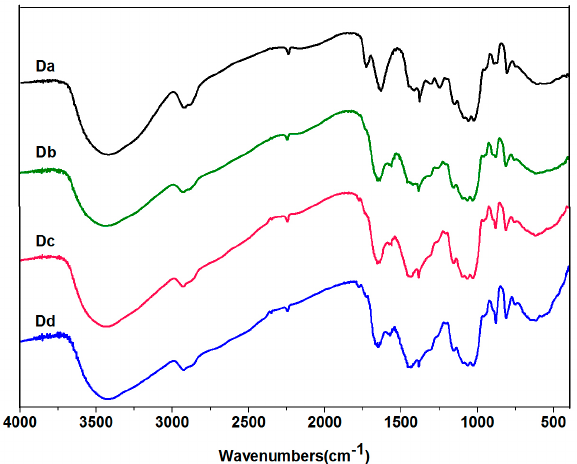
Figure 4. FT-IR spectra of KGM treated under the different alkali concentration (Da, Db, Dc and Dd was assigned to KGM treated under the different alkali concentration of 0%, 0.12%, 0.24%, and 0.36%, respectively).